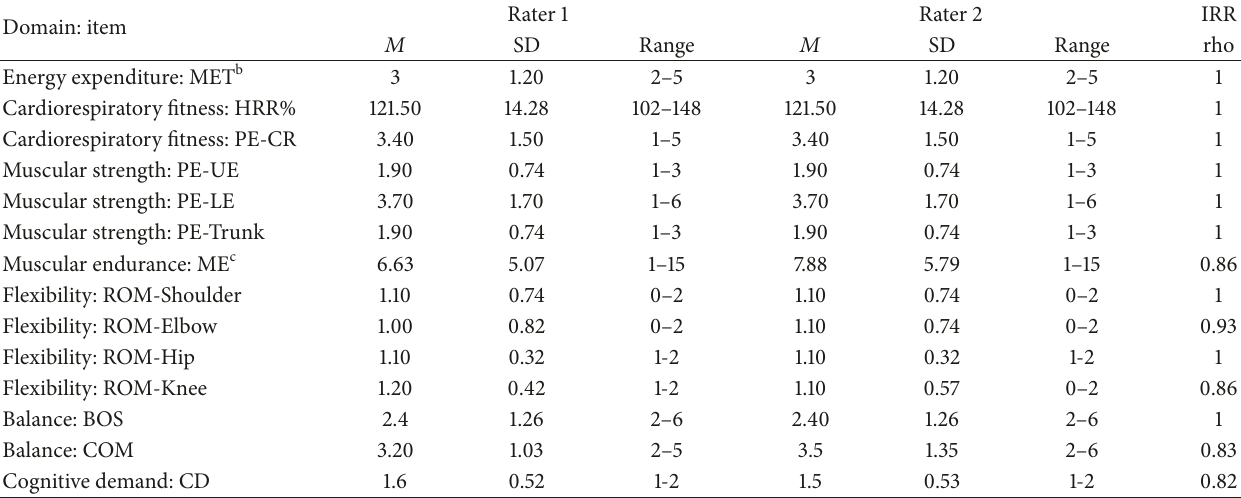
Table 3: Interrater reliability of Exergame Grading Scheme ( 𝑁 a = 10